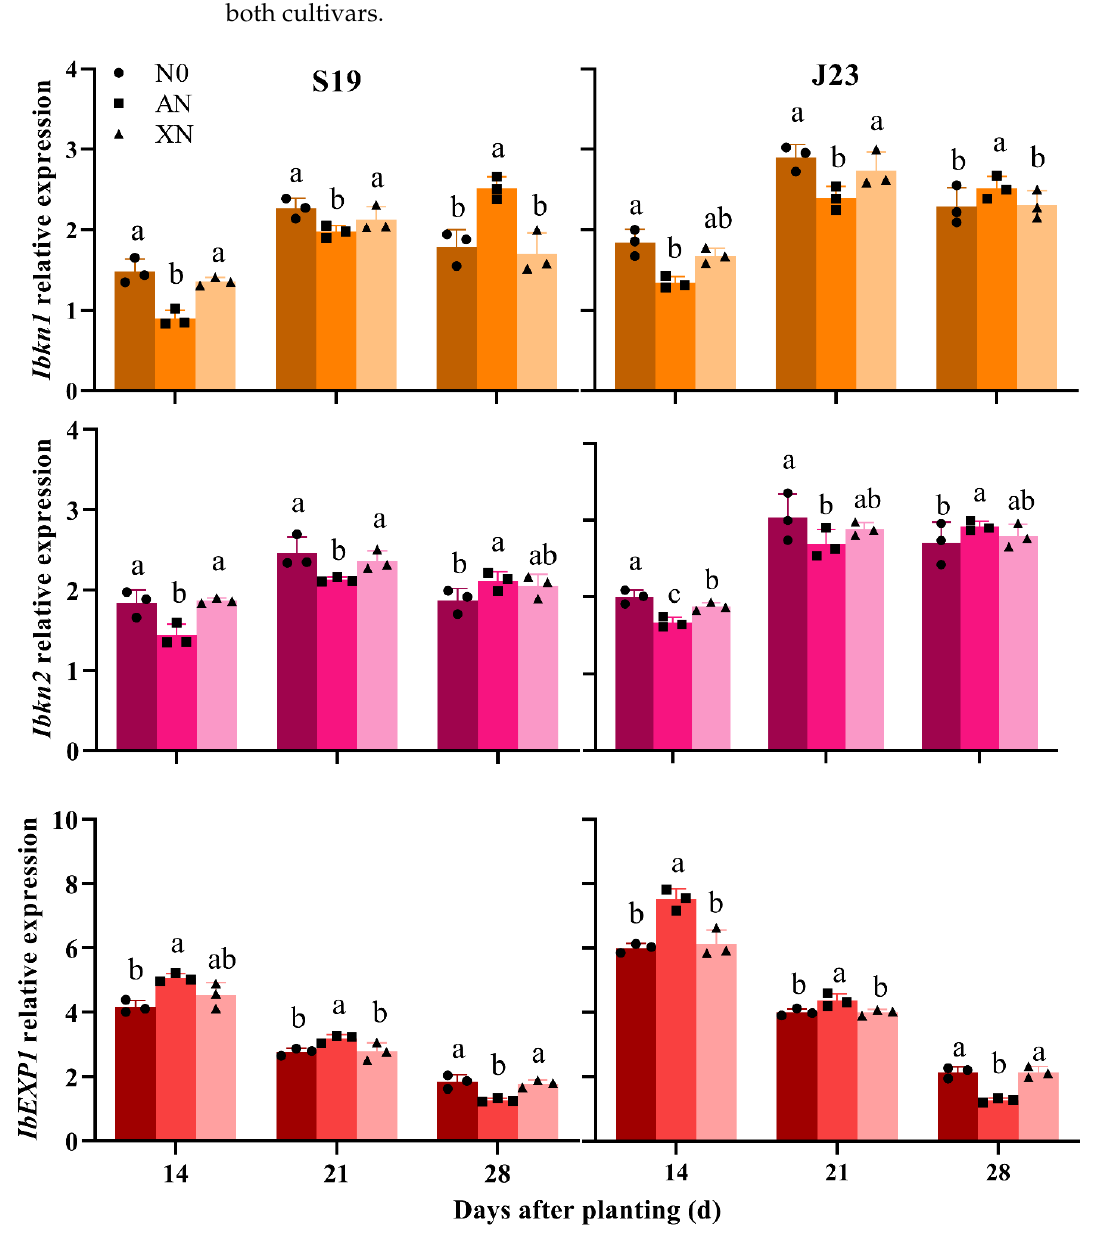
Figure 3. Relative gene expression levels of IbEXP1, Ibkn1 , and Ibkn2 in potential storage roots of sweet potato during storage root formation. Note: N0, no nitrogen fertilizer; AN, ammonium nitrogen; XN, amide nitrogen. Error bars represent standard error of the mean (three biological repeats), and different letters (a–c) indicate significant differences between N treatments ( p < 0.05).